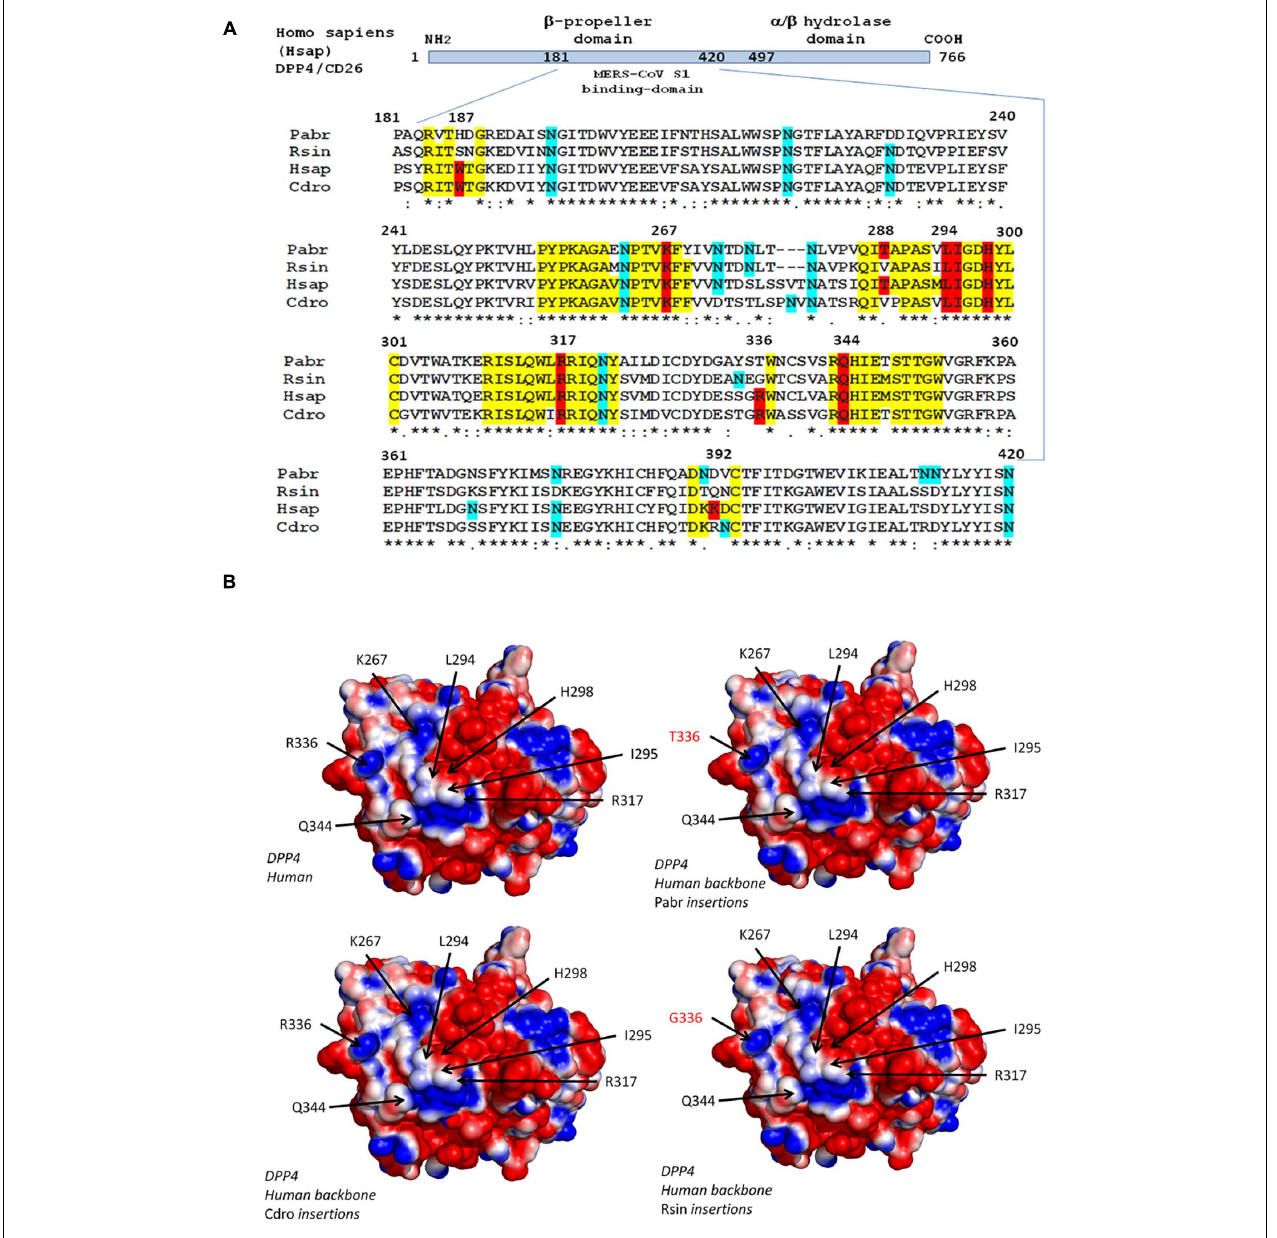
FIGURE 2 | Polymorphism of the DPP4 receptor. (A) DPP4 multiple sequence alignments. Schematic representation of the DPP4 protein organization (upper panel). The MERS-CoV S1 spike binding site is located in a region of DPP4 that extends from amino acid position 181 to amino acid 420. A clustal omega multiple sequence alignment (EMBL-EBI bioinformatic tool; Copyright EMBL 2020), spanning the 181-420 region of DPP4 from Pipistrella abramus (Pabr), Rhinolophus sinicus (Rsin), Homo sapiens (Hsap), and Camelus dromedarius (Cdro) is shown (lower panel). All DPP4 sequences were downloaded from Genbank (NCBI): Homo sapiens (GenBank: AAH13329.2); Camelus dromedarius (GenBank: AIG55259.1); Rhinolophus sinicus (GenBank: AZO92863.1); Pipistrellus abramus (GenBank: AZO922861.1). Within the amino acid sequences of DPP4 important for MERS-CoV spike binding, the conserved amino acids are highlighted in yellow, those critical for MERS-CoV-DPP4 binding are highlighted in red and the potential N-glycosylation sites are highlighted in blue. (B) 3-D analysis and electrostatic potential surface potential of the DPP4 receptor. The 3-D structure of DPP4 was retrieved according to the published data (PDB : 6M1D and 4L72). Critical amino acid sequences required to allow coronaviruses spike binding to human DPP4 were substituted by the corresponding sequence from Rhinolophus sinicus , Pipistrella abramus and Camelus dromedarius into a human DPP4 backbone sequence to determine whether or not these substitutions may change the 3-D structure of the receptors. Protein modeling for these chimeric sequences was performed using the Phyre2 server (Kelley et al., 2015). The PyMOL 1.8.0 software (https://sourceforge. net/projects/pymol/files/pymol/1.8/) and the Adaptive Poisson-Boltzmann Solver (APBS) tools plugin (https://pymolwiki.org/index.php/APBS) was used to generate electrostatic potential surfaces of the human receptors and their modified chimeric versions. The red color indicates an excess of negative charges near the surface and the blue color arises from a positively charged surface, while white is neutral.